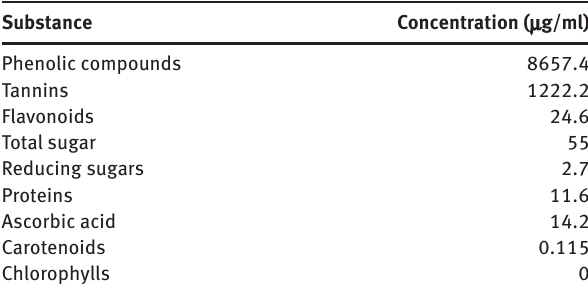
Table 1: Amount of effective biomolecules for biosynthesis of silver nanoparticles (AgNPs).